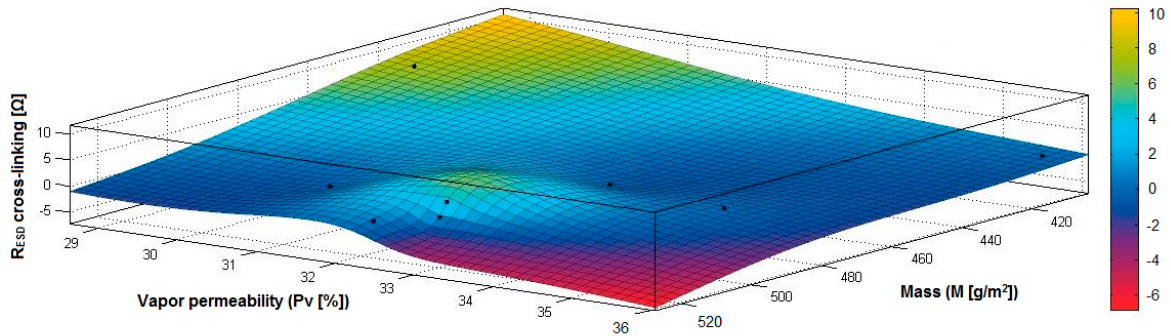
Figure 37. 3D representation R ESD = f(M, Pv) for samples preliminarily treated in RF plasma O 2 using RF 2 generator and power 100 W.